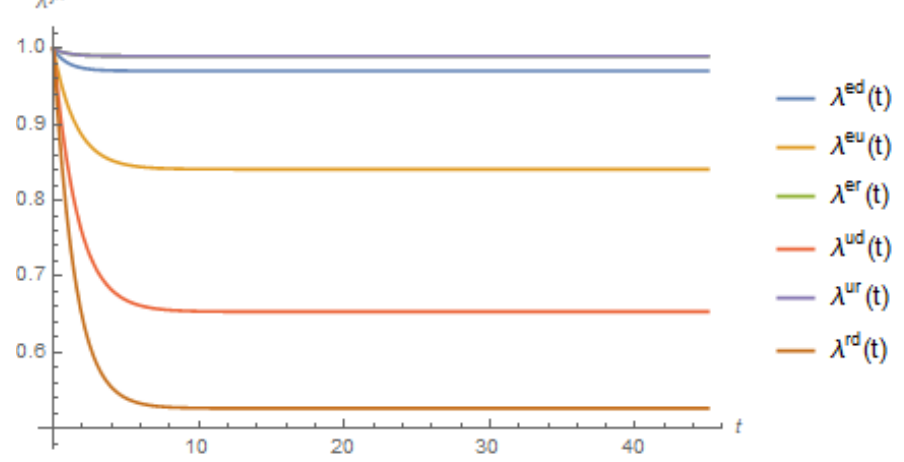
Figure 4. Six decrement probabilities under the jump-diffusion process when ρ ( j ) = 0 for all states, as a function of time t